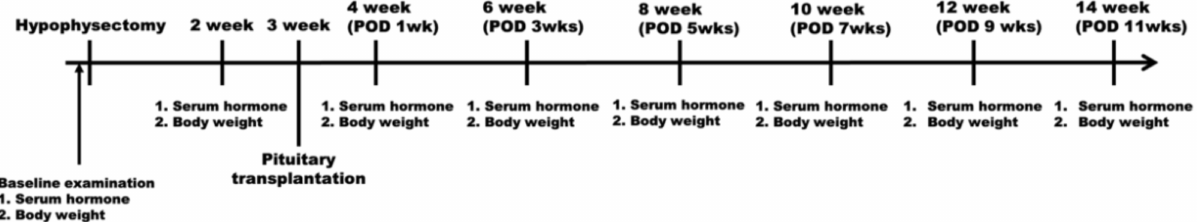
Figure 2. The study protocol for assessing hormonal and body weight change after pituitary transplantation into the omentum of an hypophysectomized